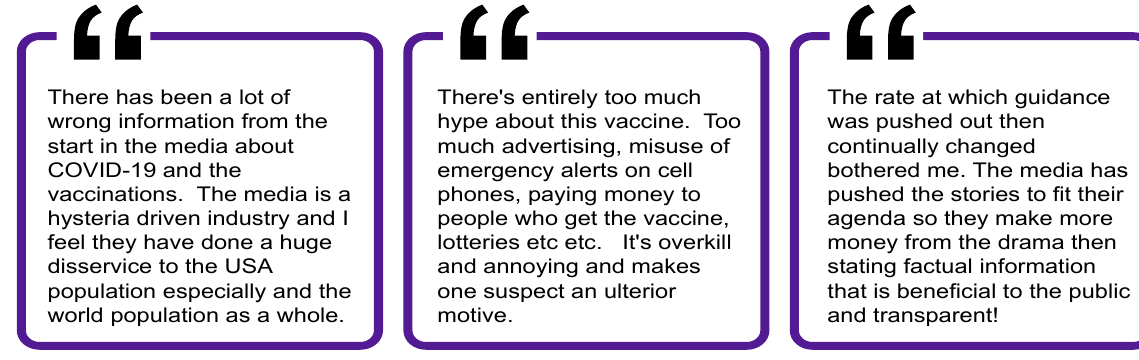
Figure 6. Participant perspectives regarding mistrust in media.